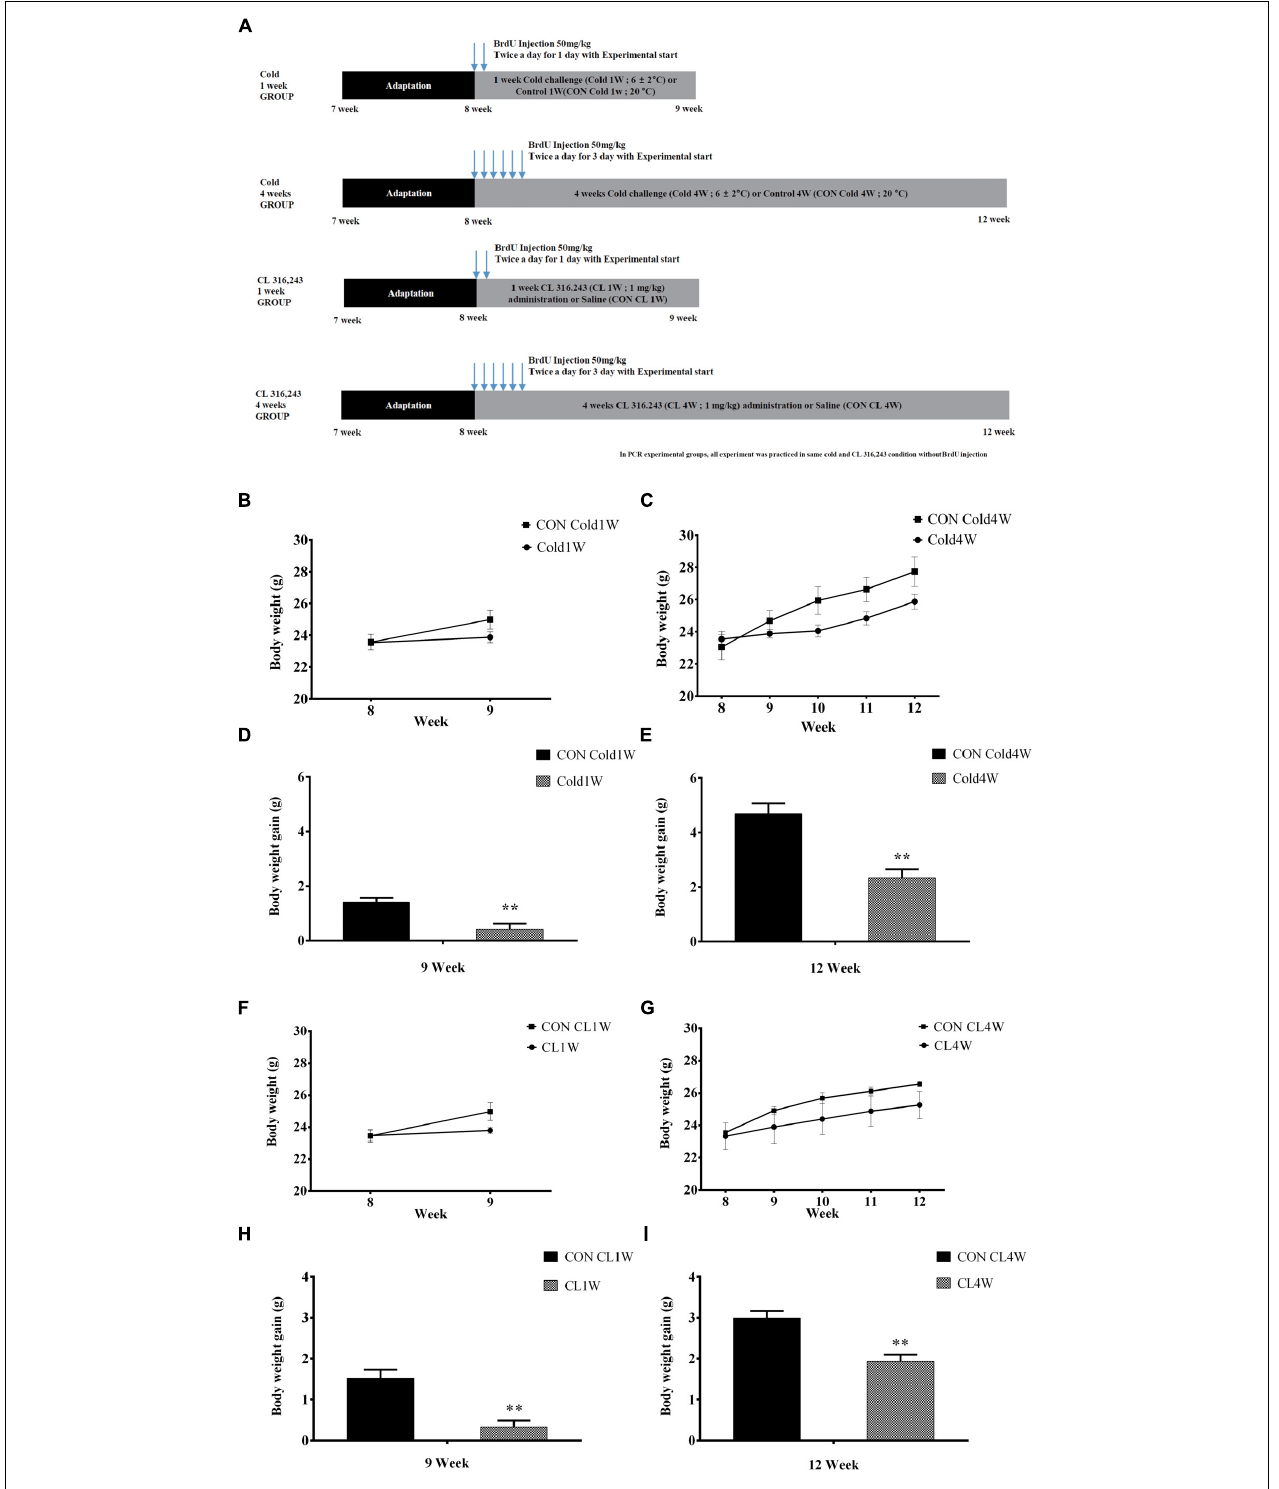
FIGURE 1 | Schematic demonstration of the experimental design (A) and effects of cold challenge or CL 316,243 treatment on body weight (B,C,F,G) and body weight gain (D,E,H,I) during experimental periods. Body weight and body weight gain changed with age and after cold challenge or CL 316,243 treatment for 1 week or 4 weeks ( n = 5 per group). ∗∗ indicates a significant difference compared with the control group ( p < 0.01). Data are shown as mean ± or + standard error of means (SEM).